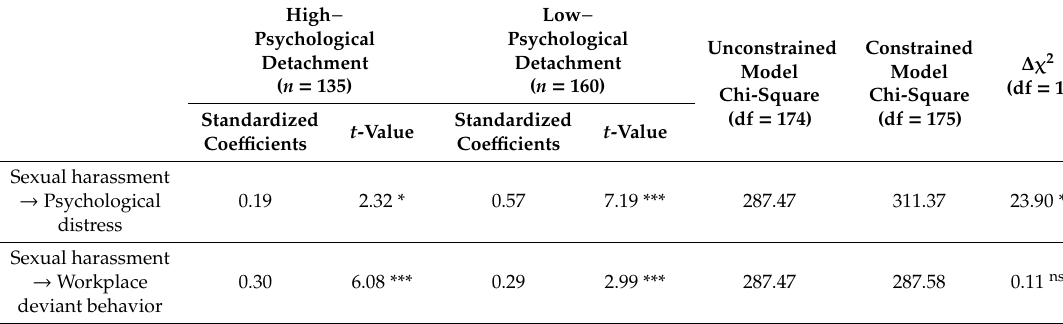
Table 5. Moderating e ff ects of employees’ psychological